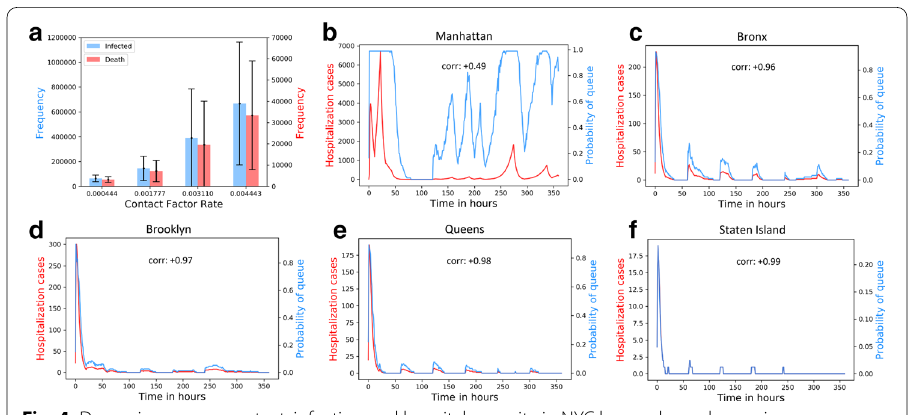
Fig. 4 Dynamics among contact, infection and hospital capacity in NYC boroughs: a change in mean infected and death numbers across boroughs with contact indices k ; b – f Change in number of hospitalization and probability of queue over time, for each borough